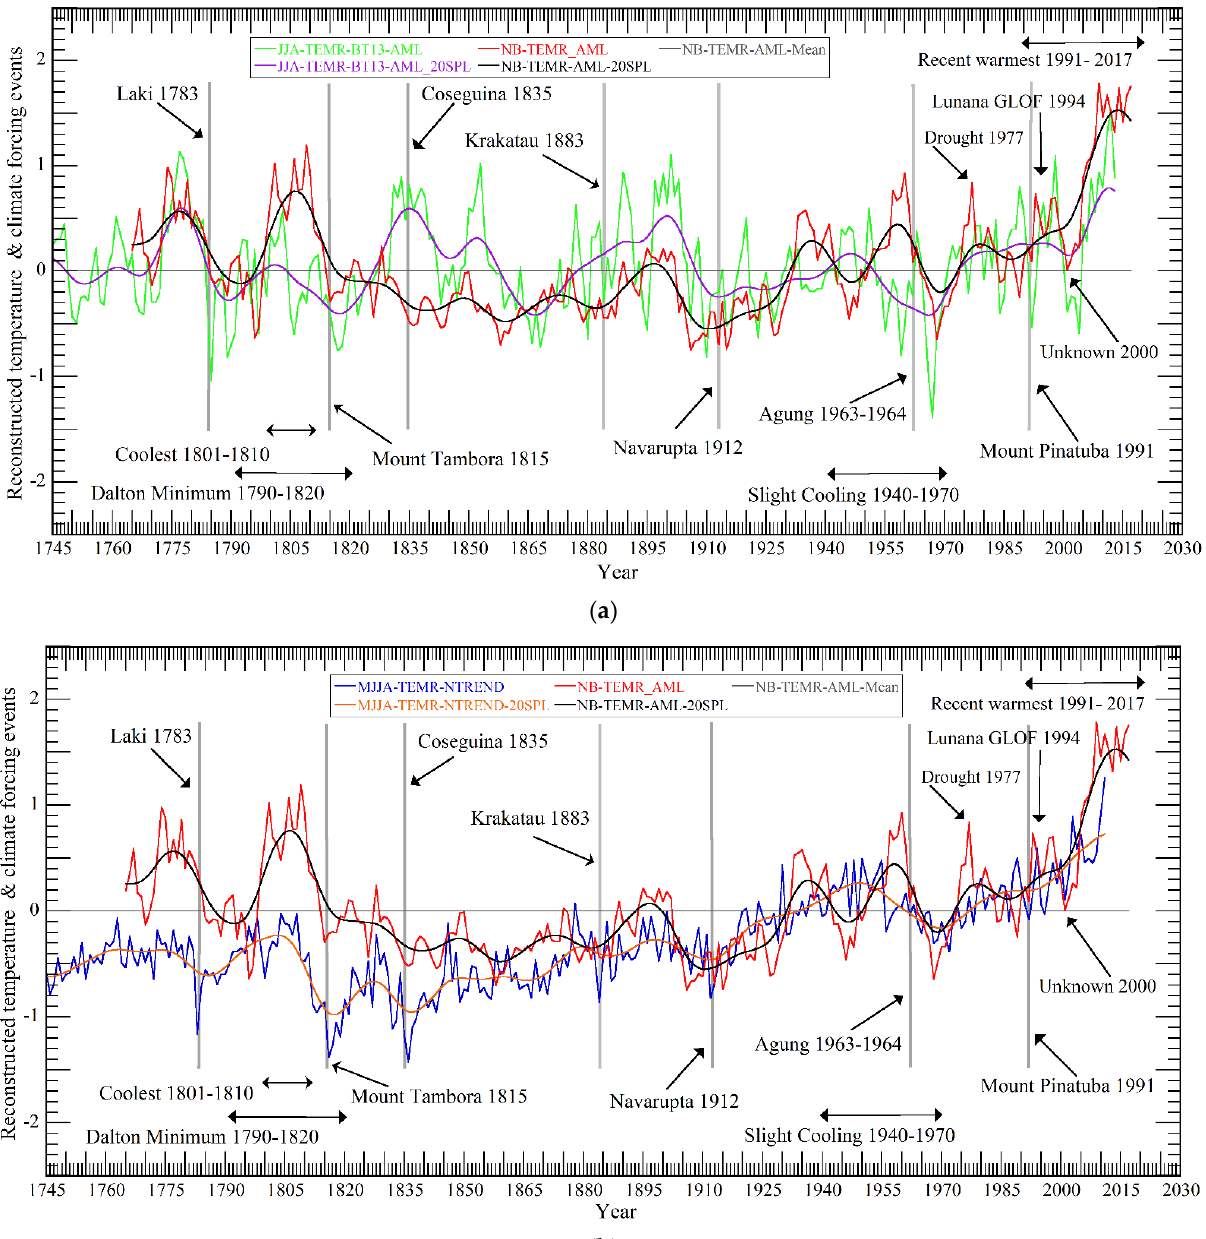
Figure 9. NB-TEMR depicted with documented volcanic dates together with JJA − TEMR-BT13, and MJJA − TEMR-NTREND, respectively. ( a ) NB − TEMR (red with black spline line) with JJA − TEMR − BT13 (lime with purple spline line). ( b ) NB-TEMR (red with black spline line) with MJJA − TEMR − NTREND (blue with orange spline line). Above reconstructions are superimposed by approximate timespans of Dalton solar Minimum, eight volcanic eruptions and some cool and warm periods. The reconstructions are expressed as anomalies from the 1901—-2000 mean (horizontal thick grey line). Reconstruction data has been filtered by 20-year low pass filtered